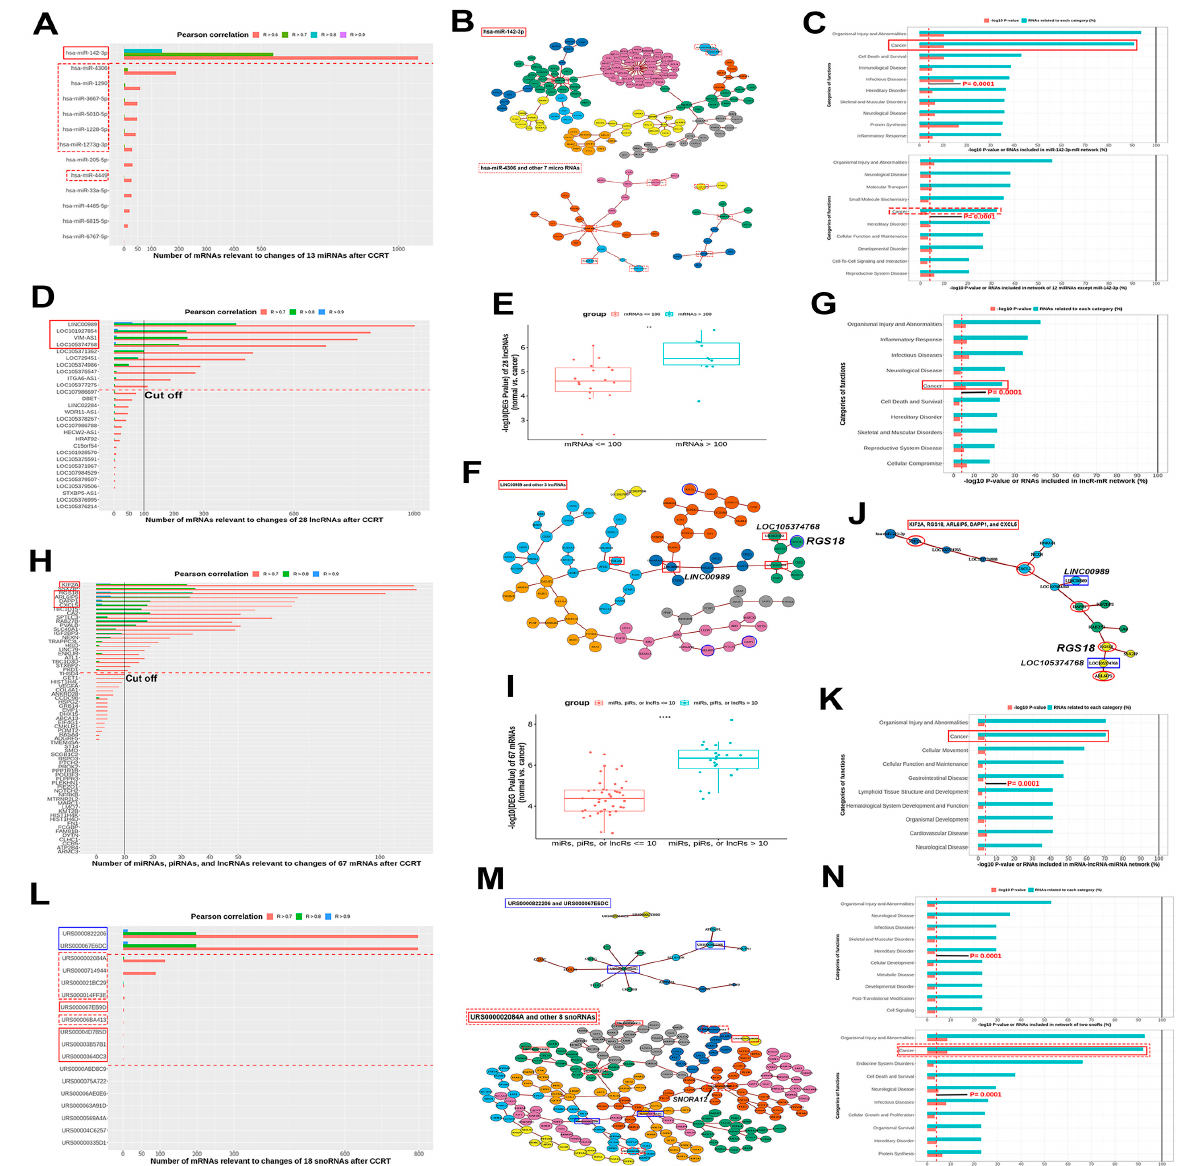
Figure 4. Biological screening of miRNAs, lncRNAs, mRNAs, and snoRNAs associated with cervical cancer. ( A ) A bar chart of the number and Pearson’s correlation of mRNAs relative to the initial 13 miRNAs. ( B ) A network of 139 mRNAs relative to miR-142-3p and the 13 miRNAs (upper), and a network of 28 mRNAs relative to other eight miRNAs and 13 miRNAs (lower). ( C ) The top 10 categories by relevance are sorted by percentage of RNAs relative to each category in a network with miR-142-3p (upper) and eight other miRNAs (lower). ( D ) A bar chart of the number and Pearson’s correlation of mRNAs relative to the 28 initially selected lncRNAs. ( E ) A comparison of − log 10 (DEG p -values) between lncRNAs with related mRNAs > 100 and those with related mRNAs ≤ 100. ( F ) A network of 76 mRNAs whose expression is affected by four lncRNAs with R > 0.9 and 28 lncRNAs. ( G ) The top 10 categories by relevance are sorted by percentage of RNAs relative to each category in the lncRNA-mRNA network. ( H ) A bar chart of the number and Pearson’s correlation of miRNAs, piRNAs, and lncRNAs relative to the initial 67 selected mRNAs. ( I ) A comparison of − log 10 (DEG p -values) between mRNAs with related ncRNAs > 10 and ncRNAs ≤ 10. ( J ) A network of six ncRNAs whose expression is altered by five mRNAs with R > 0.9 and the 68 mRNAs. ( K ) The top 10 categories by relevance are sorted by percentage of RNAs relative to each category in the mRNA-ncRNA network. ( L ) A bar chart of the number and Pearson’s correlation of mRNAs relative to the initial 18 selected snoRNAs. ( M ) A network of 13 mRNAs affected by URS0000822206 and URS000067E6DC (upper), and a network of 207 mRNAs relative to nine other snoRNAs (lower). ( N ) The top 10 categories by relevance are sorted by percentage of RNAs relative to each category in the networks of two (upper) and nine snoRNAs